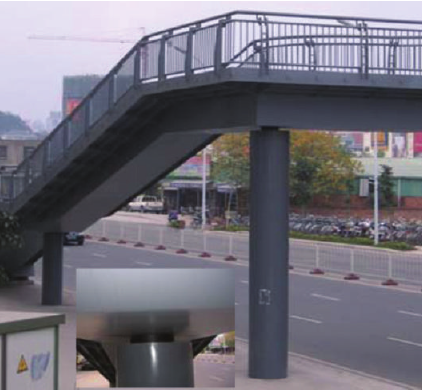
Figure 1: CFST column subjected to partial compression